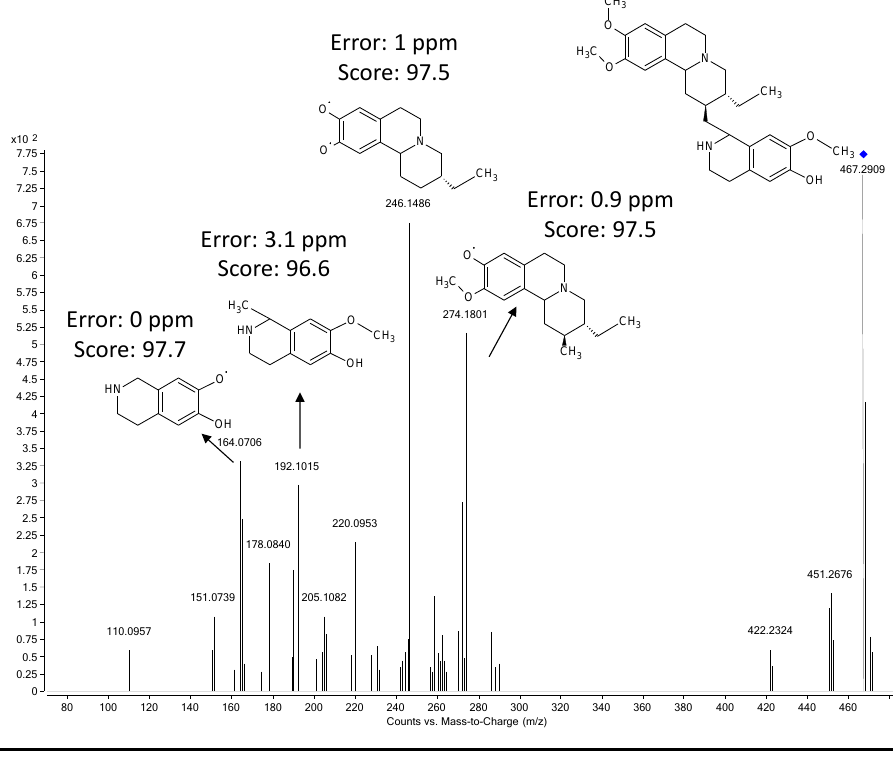
Figure 4. Proposed metabolite fragment structures for cephaeline based on MSC